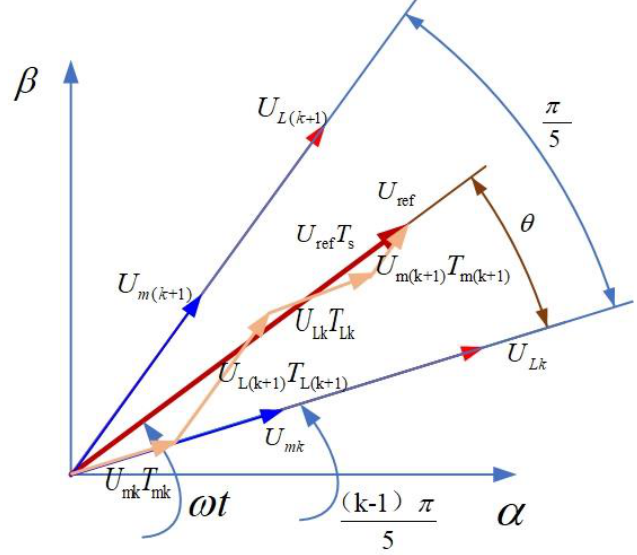
Figure 4. Composition of a reference vector based on NFSVPWM (the Nearest Four-vector SVPWM algorithm) in sector k.